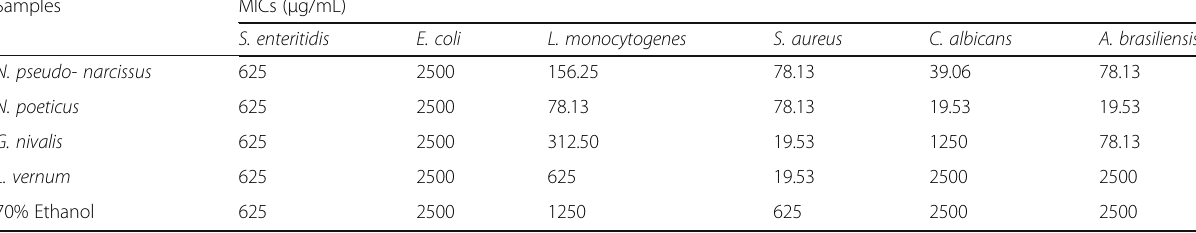
Table 4 Minimum inhibitory concentration (MIC) values